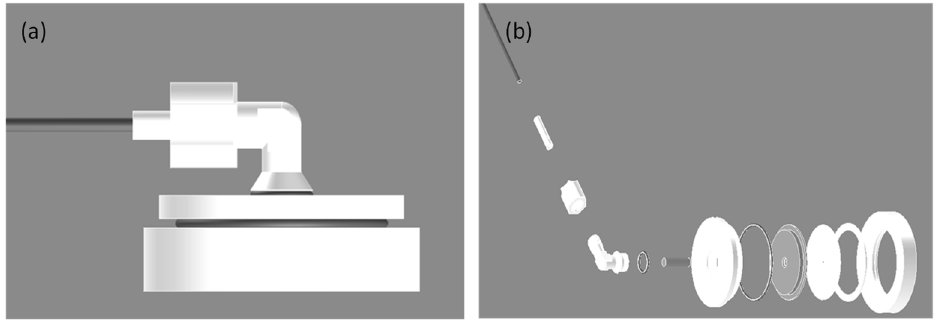
Figure 3. Electrochemical mold for anodization and electrochemical test; ( a ) the combination diagram, ( b ) the exploded diagram.